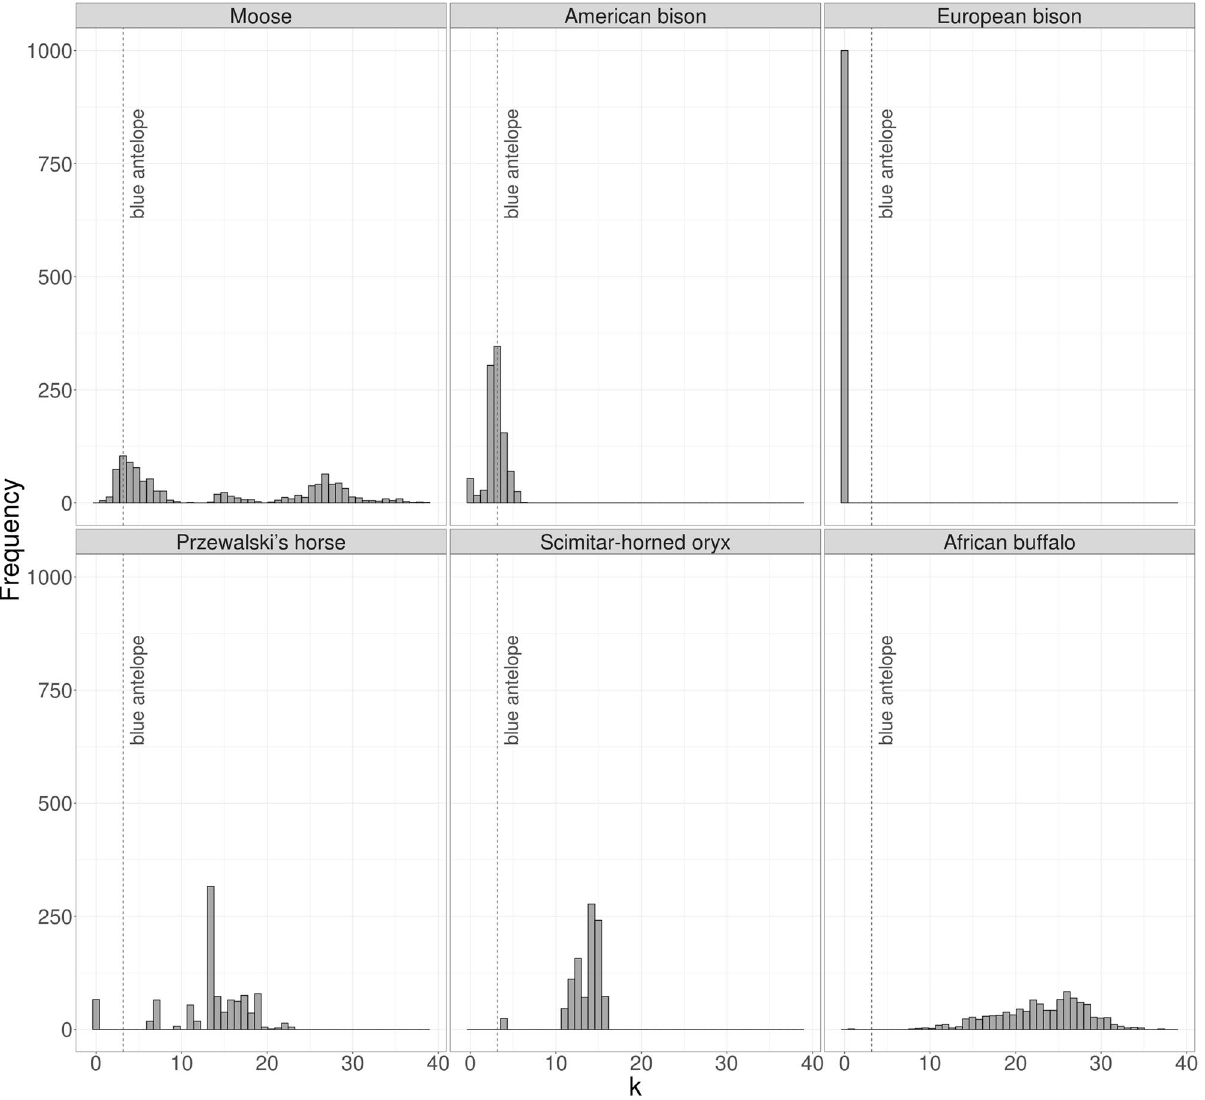
Figure 5. Mitochondrial diversity comparison. Mitochondrial diversity of the four blue antelope specimens (dashed line) compared to the distribution of 1,000 replicates of the diversity of four randomly drawn sequences of six wild ungulate species based on the alignment of homologous positions of the mitochondrial genome (6,061 bp in length) (shown with bins of 50, generated in RStudio v1.1.423 60 (https ://www.rstud io.com/) using R v3.63 61 (https ://www.R-proje ct.org/)). k represents the average number of substitutions between two